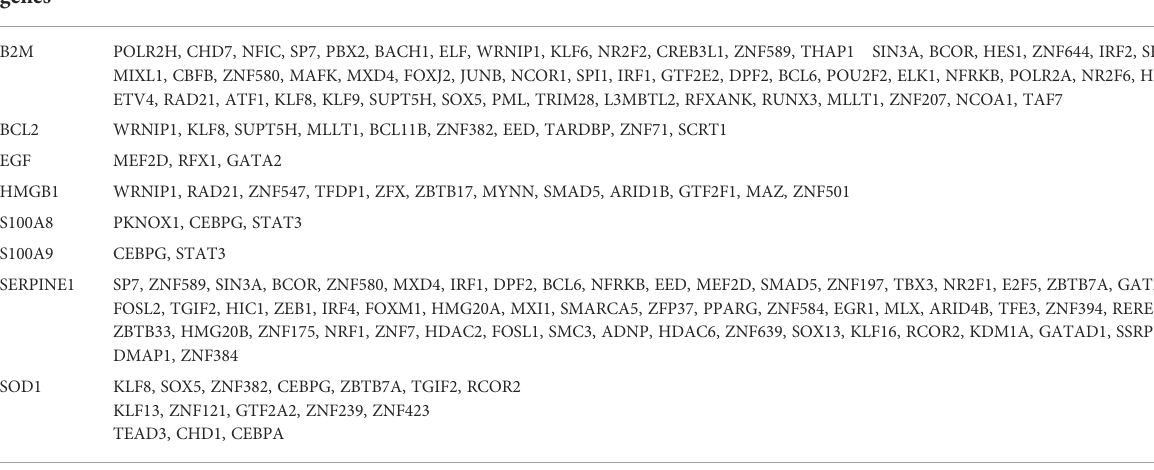
TABLE 4 TF – gene interaction.